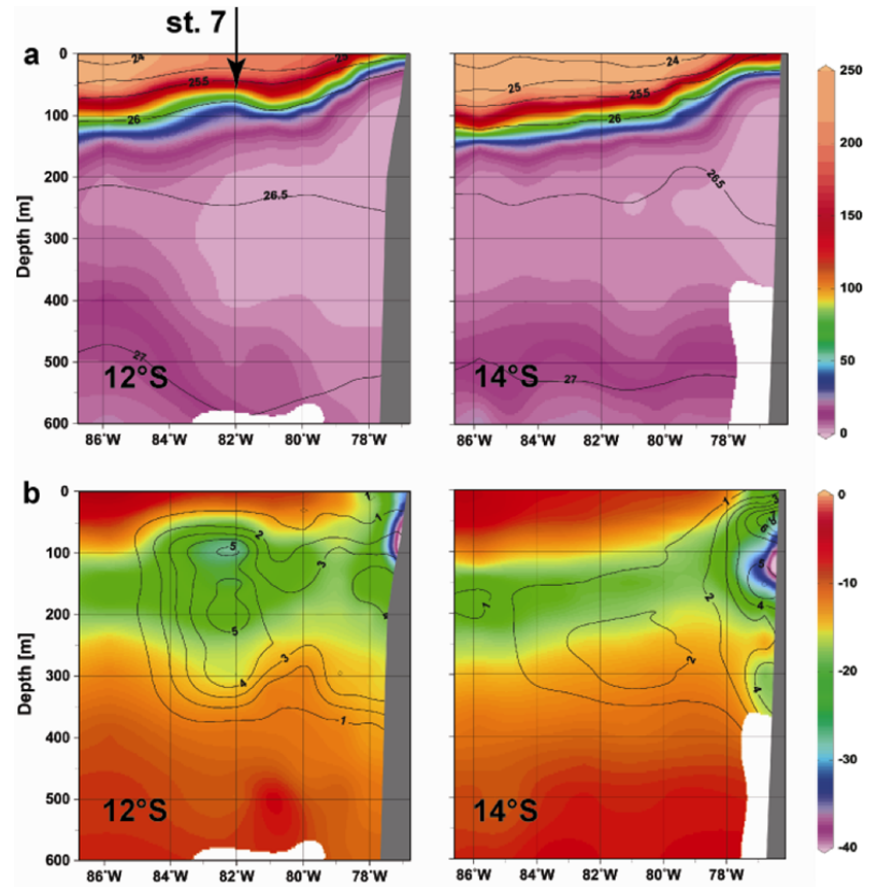
Fig. 3. Property distribution section off the Peru coast. (A) O 2 concentration (µmolkg − 1 ; color shading) and σ θ (contour lines) sections at 12 and 14 ◦ S latitude (see station positions in Fig. 1). Station 7 is part of the 12 ◦ S section and its position is marked. (B) Corresponding N 0 (color shading) and NO − concentration (contour lines) sections at 12 and 14 ◦ S. Units are in µmolkg − 1 . Data smoothing to produce this 2 visualization diminishes somewhat the extrema found at Station 7 (see Fig.